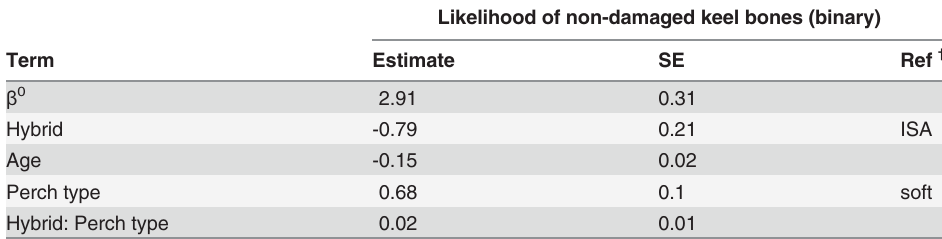
Table 1. Model output for the likelihood of non-damaged keel bones